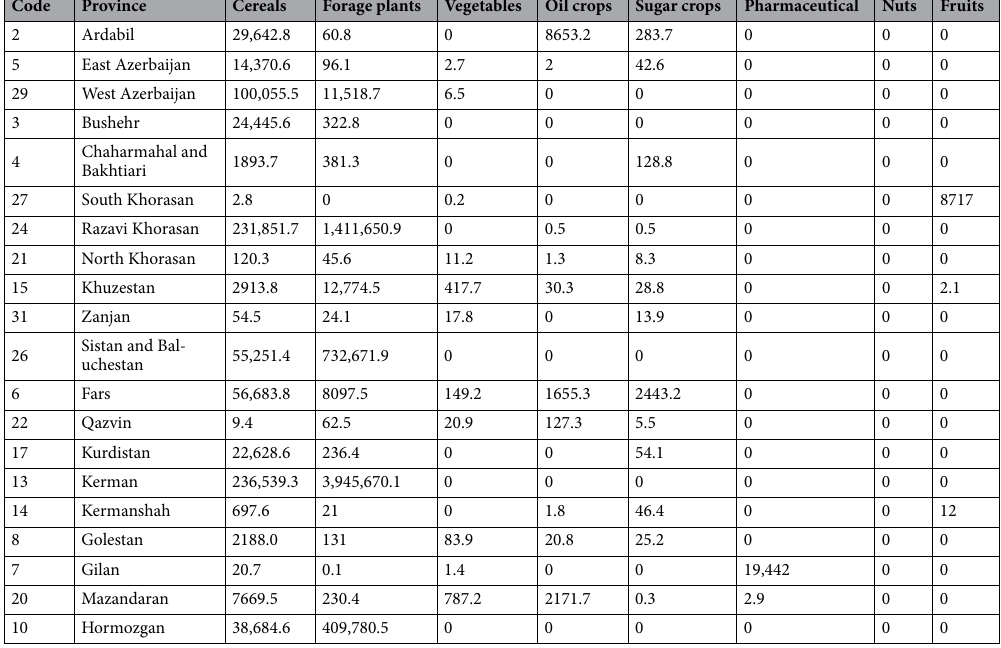
Table 3. Crop production (tons) under a modified cropping pattern. The province codes refer to the provinces shown on the map in Fig.